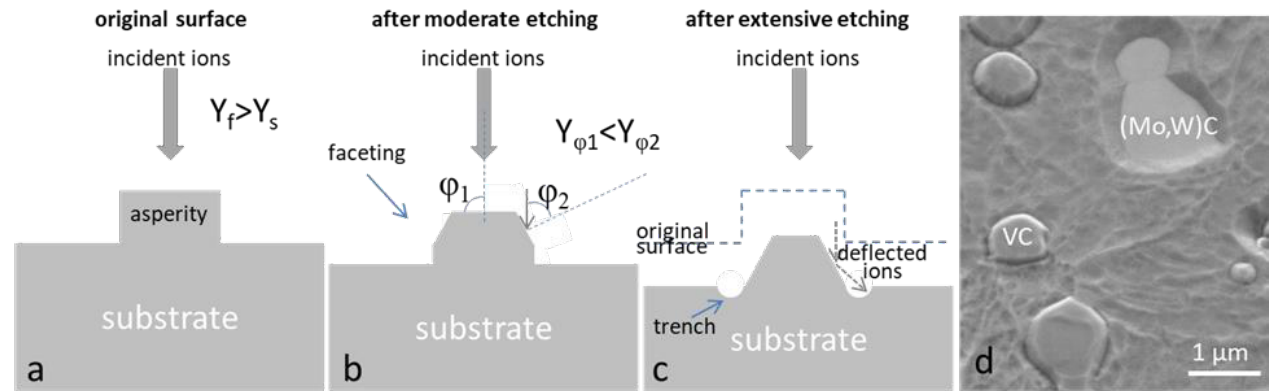
Figure 12. Schematic diagram outlining the mechanism of faceting and trench formation during ion etching of a protrusion on the substrate surface ( a – c ). Top view SEM image of ASP30 substrate after DC ion etching in BAI deposition system ( d ). In the SEM picture, we can see the faceting of carbides and the formation of trenches.